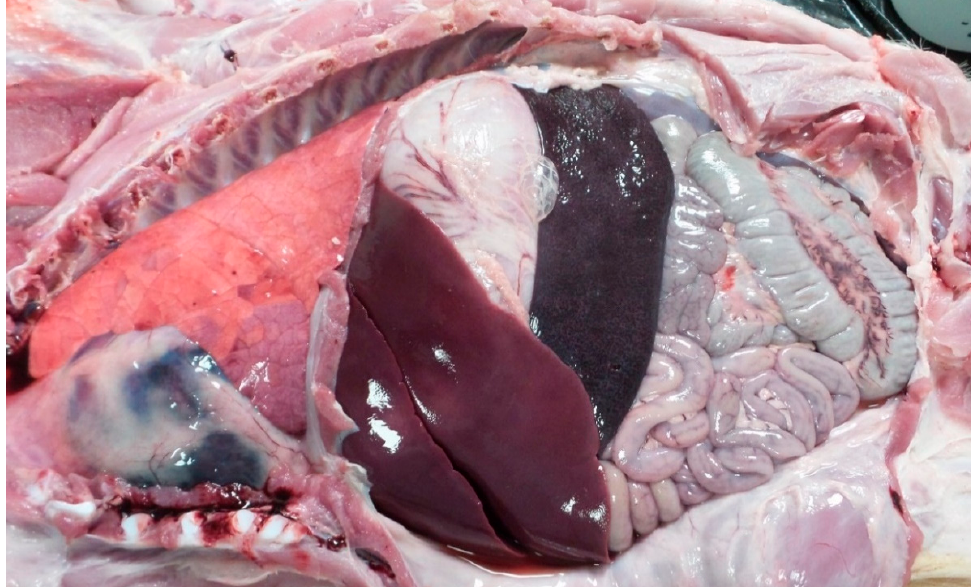
Figure 5. View of thoracic and abdominal cavities of a vaccinated pig (group 2, ID 3) subsequently challenged intramuscularly with the virulent Pol16/DP/OUT21 ASFV. Hepatomegaly, splenomegaly and ascites are evident.